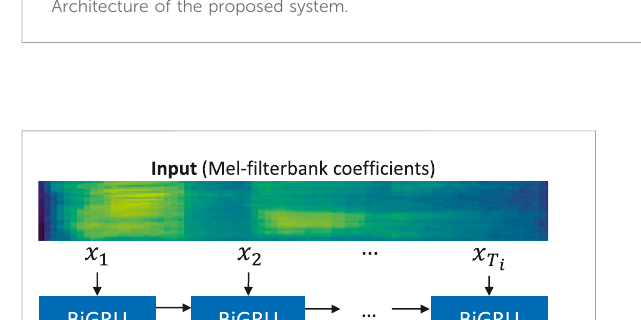
FIGURE 4 Architecture of the proposed system.